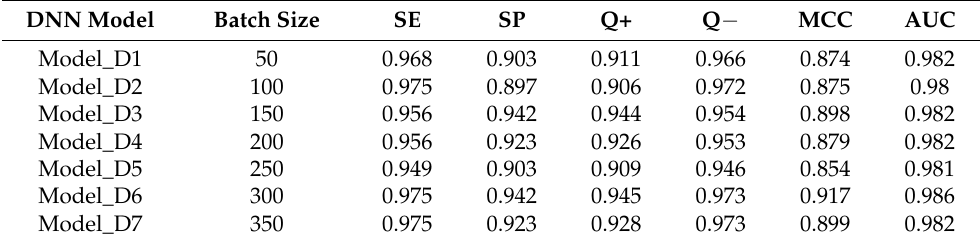
Table 1. Test results of the DNN classification models under different batch sizes.